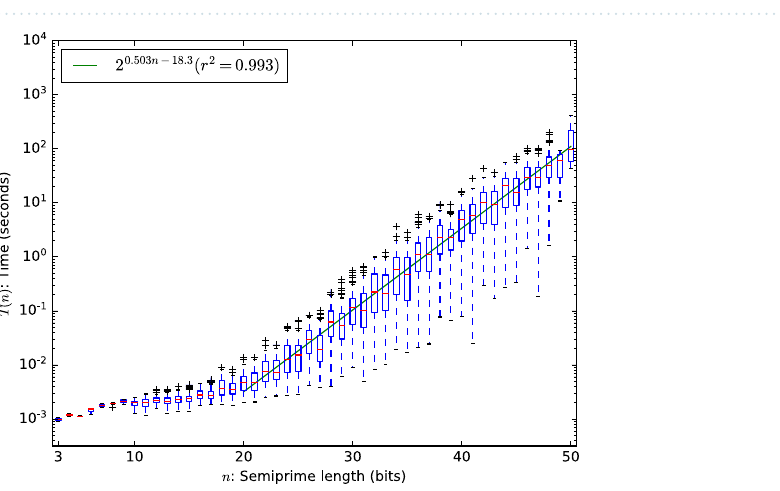
Figure 1. Runtime of MapleCOMSPS on factoring semi-primes.